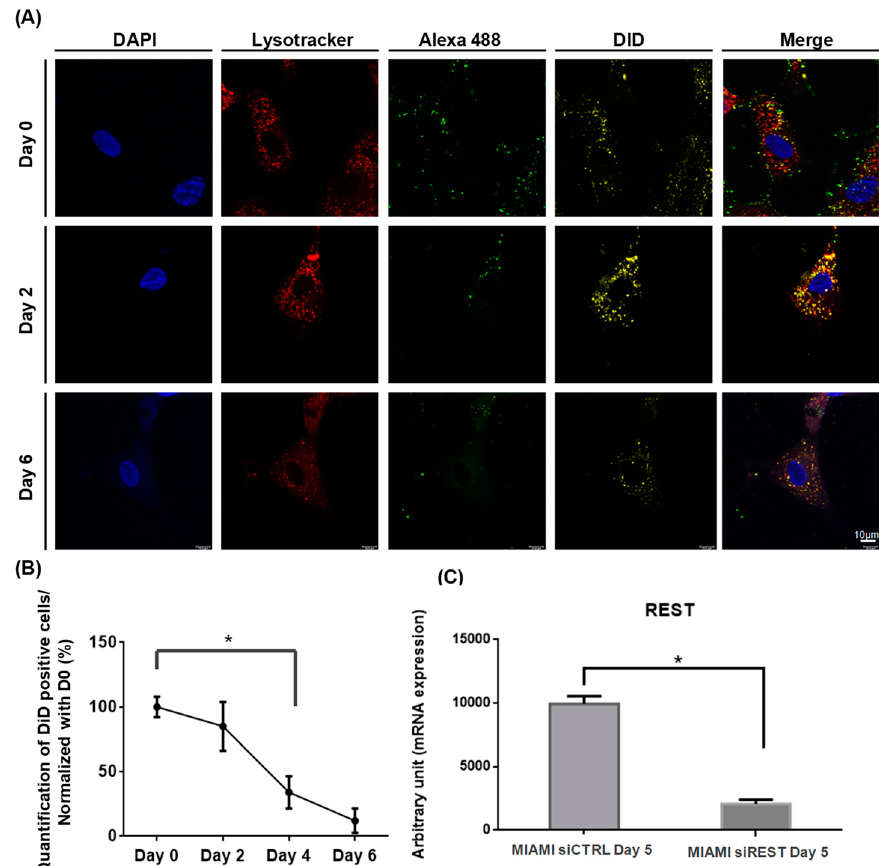
Figure 2. Cellular uptake and cell time retention of siRNA-LNC in MIAMI E / F cells. ( A ) After 4 h incubation, confocal microscopy was performed on MIAMI cells with siRNA-LNCs. Cells were fixed on glass slide and nucleus and lysosome staining were performed with DAPI (blue) and lysotracker (Red). Double fluorescent probes were used to follow siRNA and LNCs: lipophilic DiD (yellow) and Alexa488 siRNA (green). Scale bar represents 10 µ m. Analysis confirmed the internalization of siRNA-LNCs and its presence until Day 6. ( B ) DiD-positive cells representing the LNC-positive cells were counted using imageJ. 6 images per conditions in 10 × objective were selected. ( C ) The expression of REST, measured by RT-qPCR, was decreased significatively (Fold decrease: 4.80 ± 1.80) at Day 5 after transfection compared to the control. N = 3. * Significantly different means at p < 0.05.